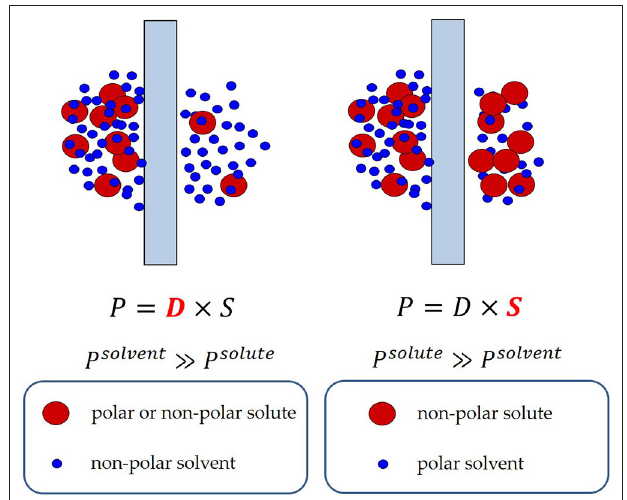
FIGURE 2 | Solvent and solute transport in PDMS-based membranes. On the right is reported the case where solute permeability exceeds solvent permeability. Solute preferential sorption is believed to be the cause of this behavior ( Postel et al.,